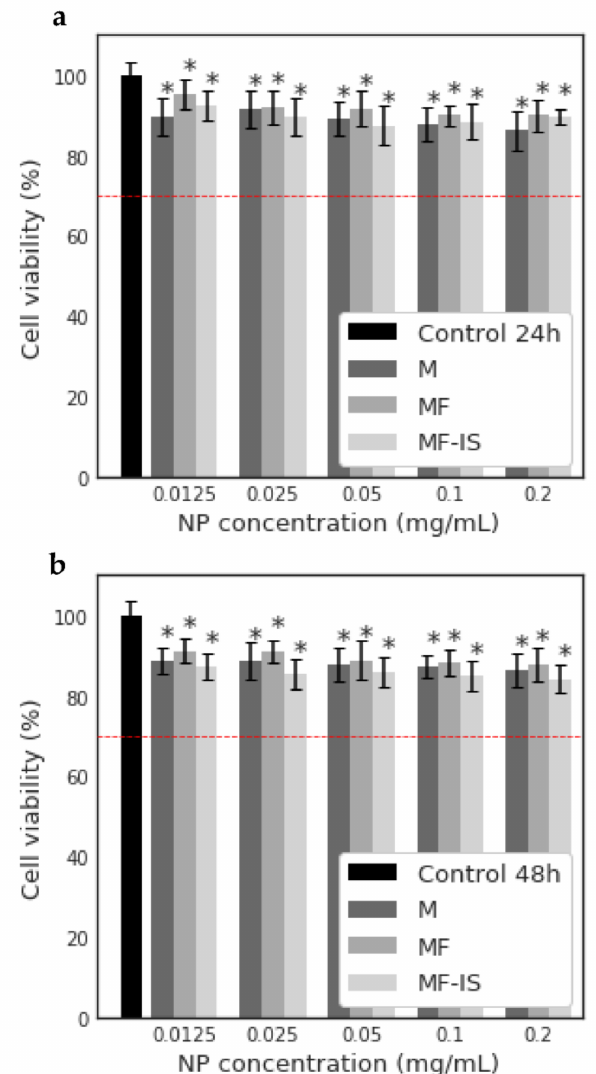
Figure 8. Relative viability (%) of MNT-1 cells after 24 ( a ) and 48 h ( b ) exposure of a range of concentrations (0.0125, 0.025, 0.05, 0.1 and 0.2 mg mL − 1 ) of pristine magnetite NP (M), fucoidan- coated magnetite NP post- synthesis (MF) and in situ (MF − IS). Results were expressed as mean ± SD from three independent experiments. Statistical differences between the samples and control are represented by * when p < 0.05. The red dotted line at 70% is the toxicity limit, according to ISO